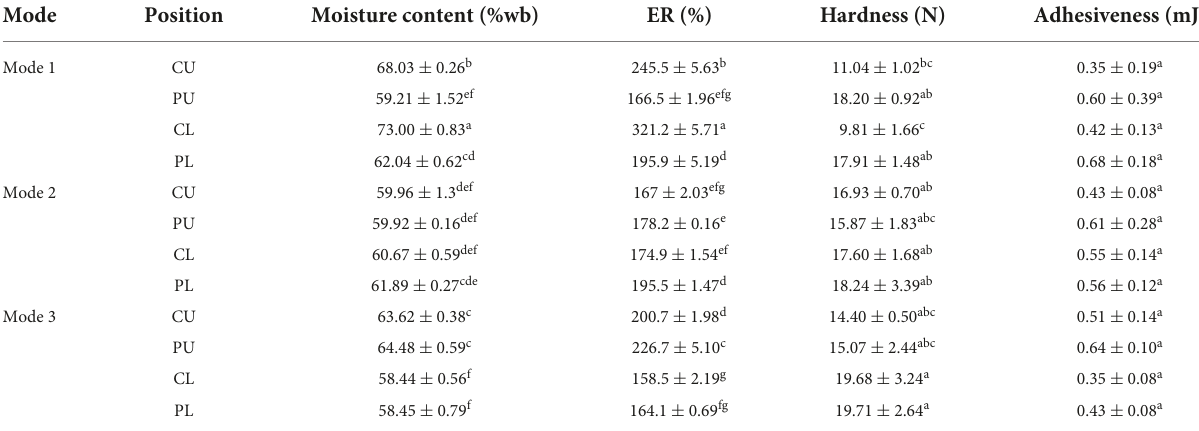
TABLE 2 Moisture content, expansion ratio and texture properties of rice under different heating